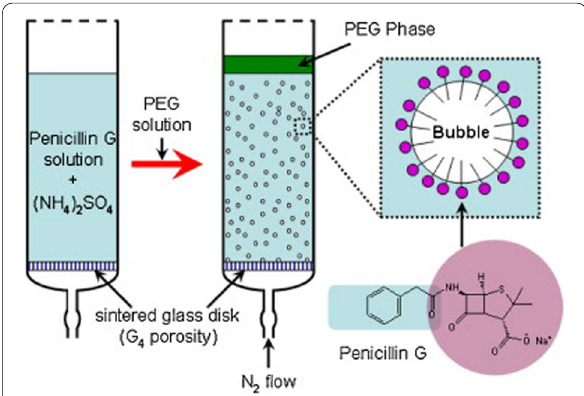
Fig. 3 Separation of penicillin G in the aqueous two-phase system (ATPF) by (Bi et al.